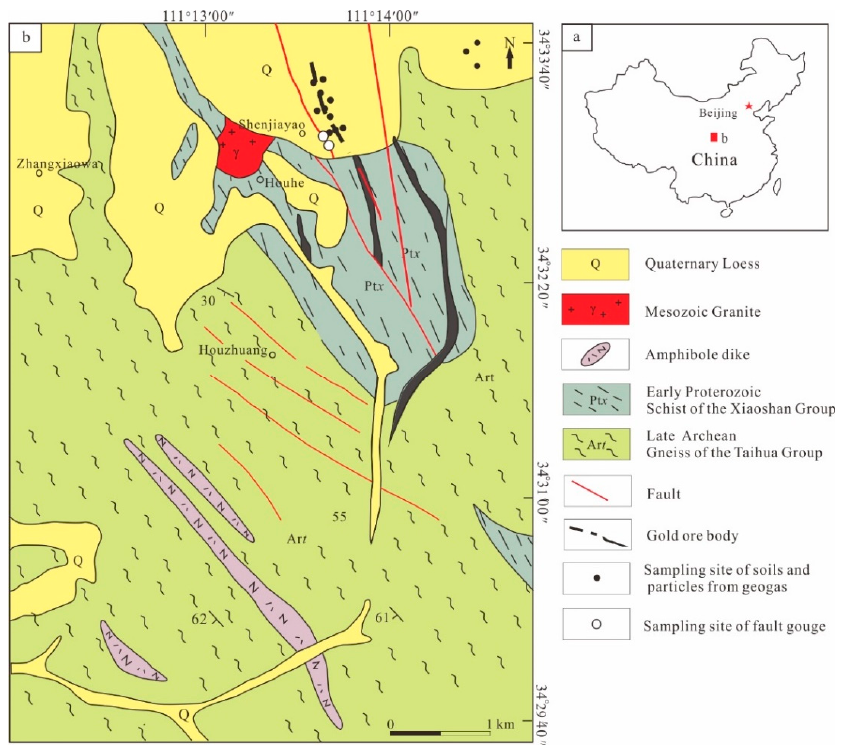
Figure 1. Geological map and sampling sites in the Shenjiayao gold deposit (modified after Chen et al. [55]).